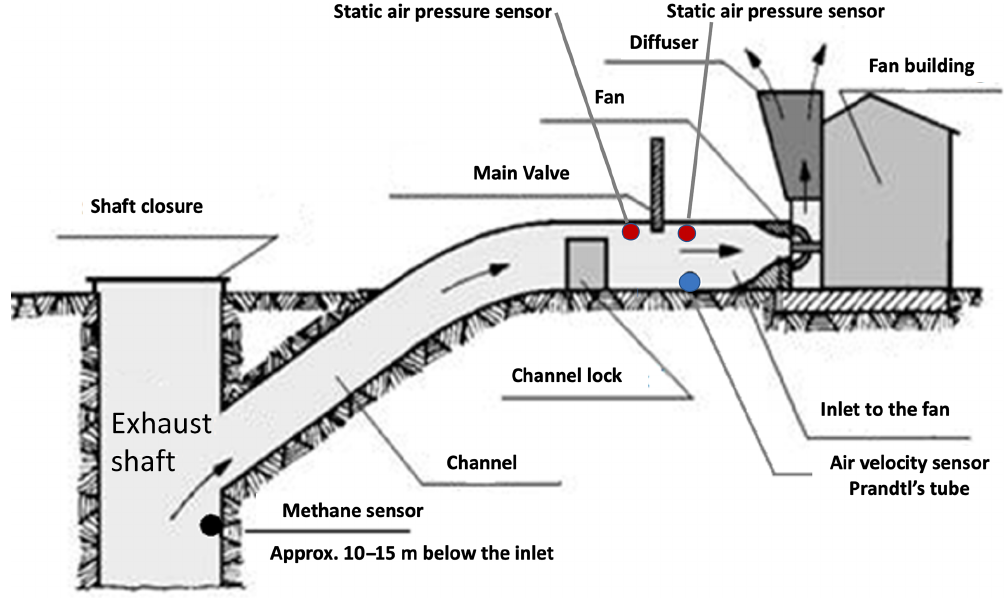
Figure 4. Scheme of a typical ventilation shaft scheme where colour dots stand for methane, velocity, and static pressure sensors; quoted after Swolkie´n (2020). The original figure was published under a Creative Commons Attribution 4.0 International 225 License, http:// creativecommons.org/licenses/by/4.0/ (last access: 12 March